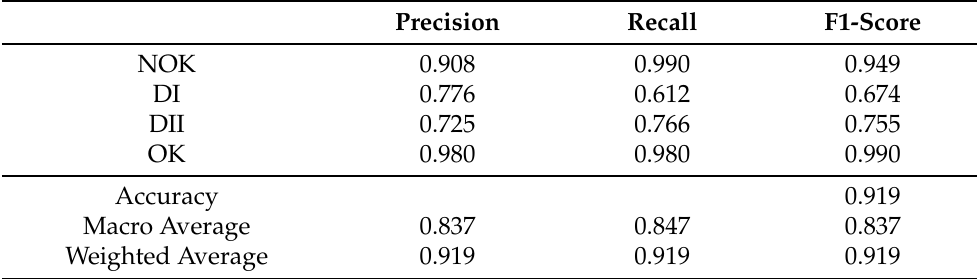
Table 9. Tederic classification